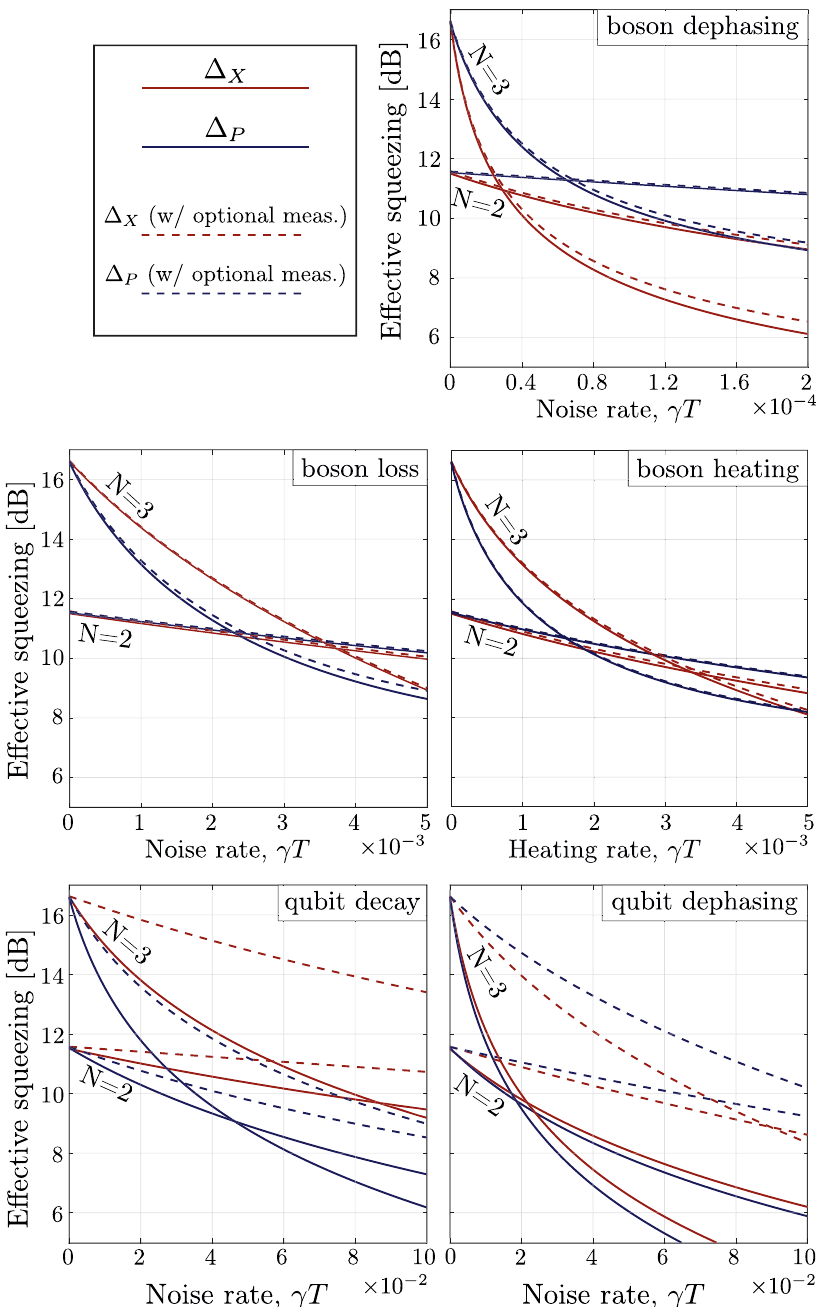
Fig. 4 Effects of physical noise sources. Effective squeezing in X and P for a square grid state as a function of noise rate for different noise sources during the preparation protocol. γ is the noise rate and T is the time required to implement e i ^ X ^ σ y and e i ^ P ^ σ x